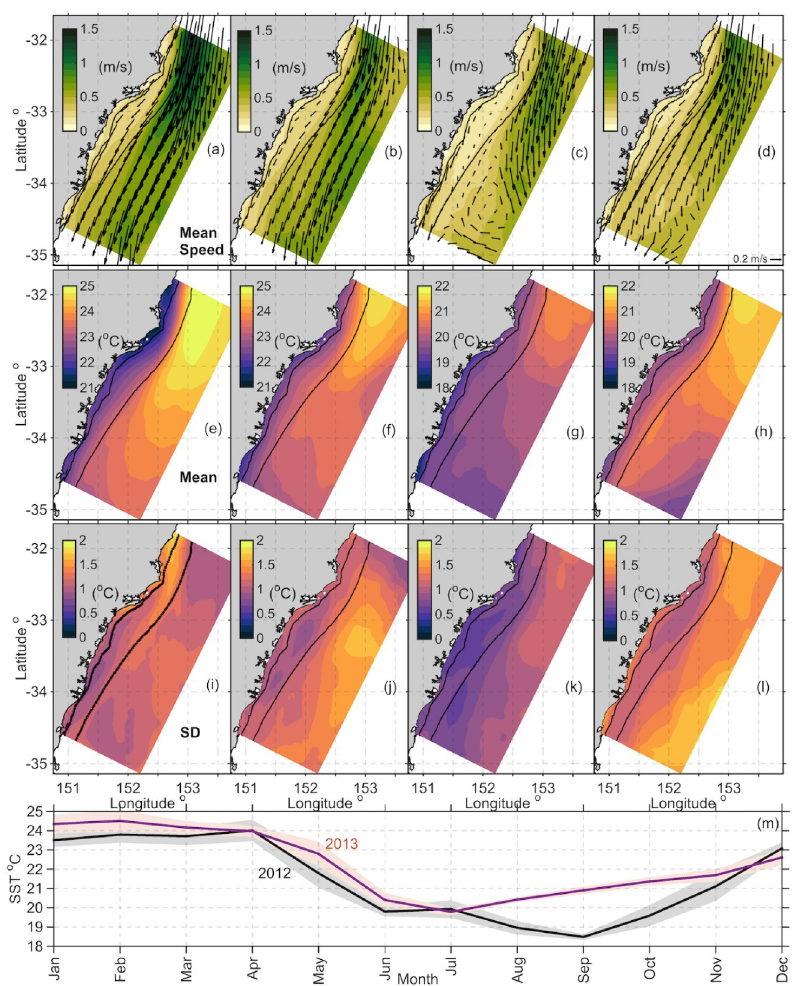
Fig 7. Domain-wide seasonal mean modelled fields. Velocity fields at the surface (a-d). Velocity vectors show the direction and colour shows the magnitude (ms -1 ) of the speed. Every 25 th vector is shown for clarity. The reference velocity arrow in the bottom right of each panel represents 0.2 ms -1 . Domain wide mean SST by season (e-h) and associated standard deviations (i-l) in ( o C). Solid black lines show the 100 m and 2000 m isobaths. Area averaged SST (m) showing monthly means for 2012 (black), 2013 (red). Shaded areas represent the standard deviations.